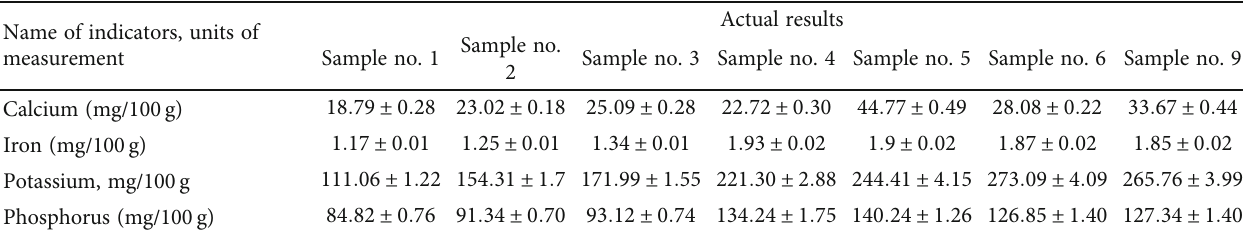
Table 8: Mineral elements of various bun formulations.